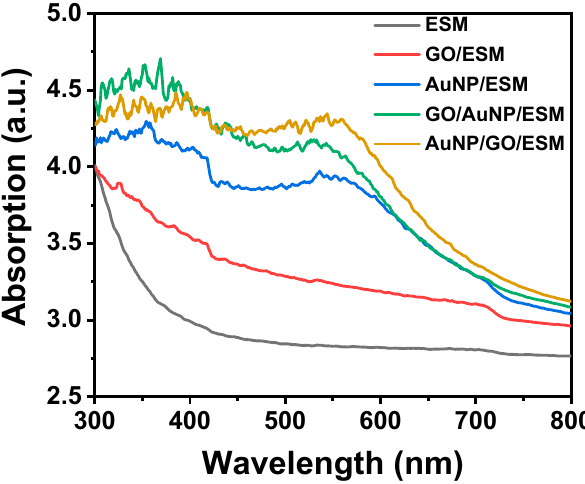
Figure 2. UV-Vis diffusion reflectance absorbance spectra of the treated ESM samples.